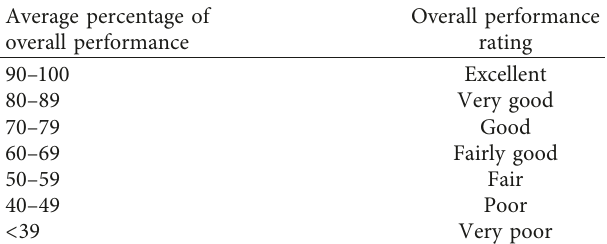
Table 5: Overall performance rating based on the range of average percentages of overall